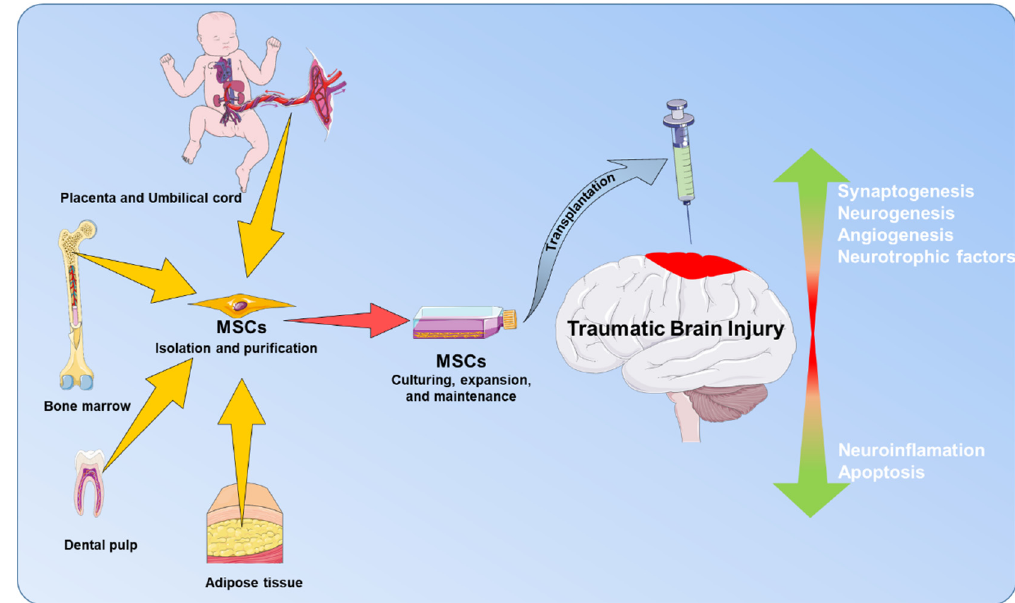
Figure 2. Summary of the therapeutic e ff ects of mesenchymal stem cells (MSCs) in TBI. Prior to transplantation, MSCs can be isolated easily from di ff erent sources such as adipose tissue, placenta and umbilical cord, bone marrow, or dental pulp. Transplantation of MSCs can increase synaptogenesis, neurogenesis, angiogenesis, and neurotrophic factors at the injured brain tissue after TBI insults. Furthermore, MSCs can inhibit neuroinflammation, and apoptosis and thereby promote neuroprotective or neurorestorative e ff ects, as well as improve functional outcomes after TBI. MSCs can reduce neuroinflammation and improve functional recovery after TBI [78].